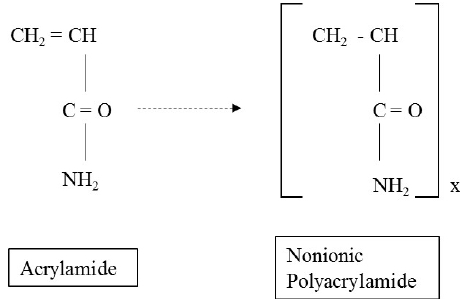
Figure 2. The basic chemical structure of polyacrylamide (PAM) [47]. Table 1. The chemical composition of polyacrylamide (PAM).